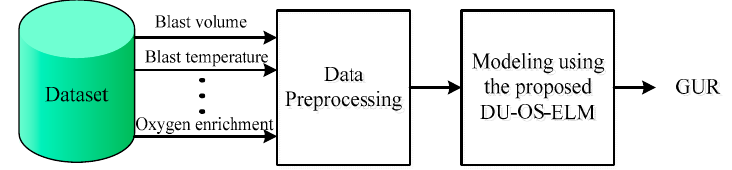
Figure 4. Main frame of the soft-sensor model for GUR prediction.